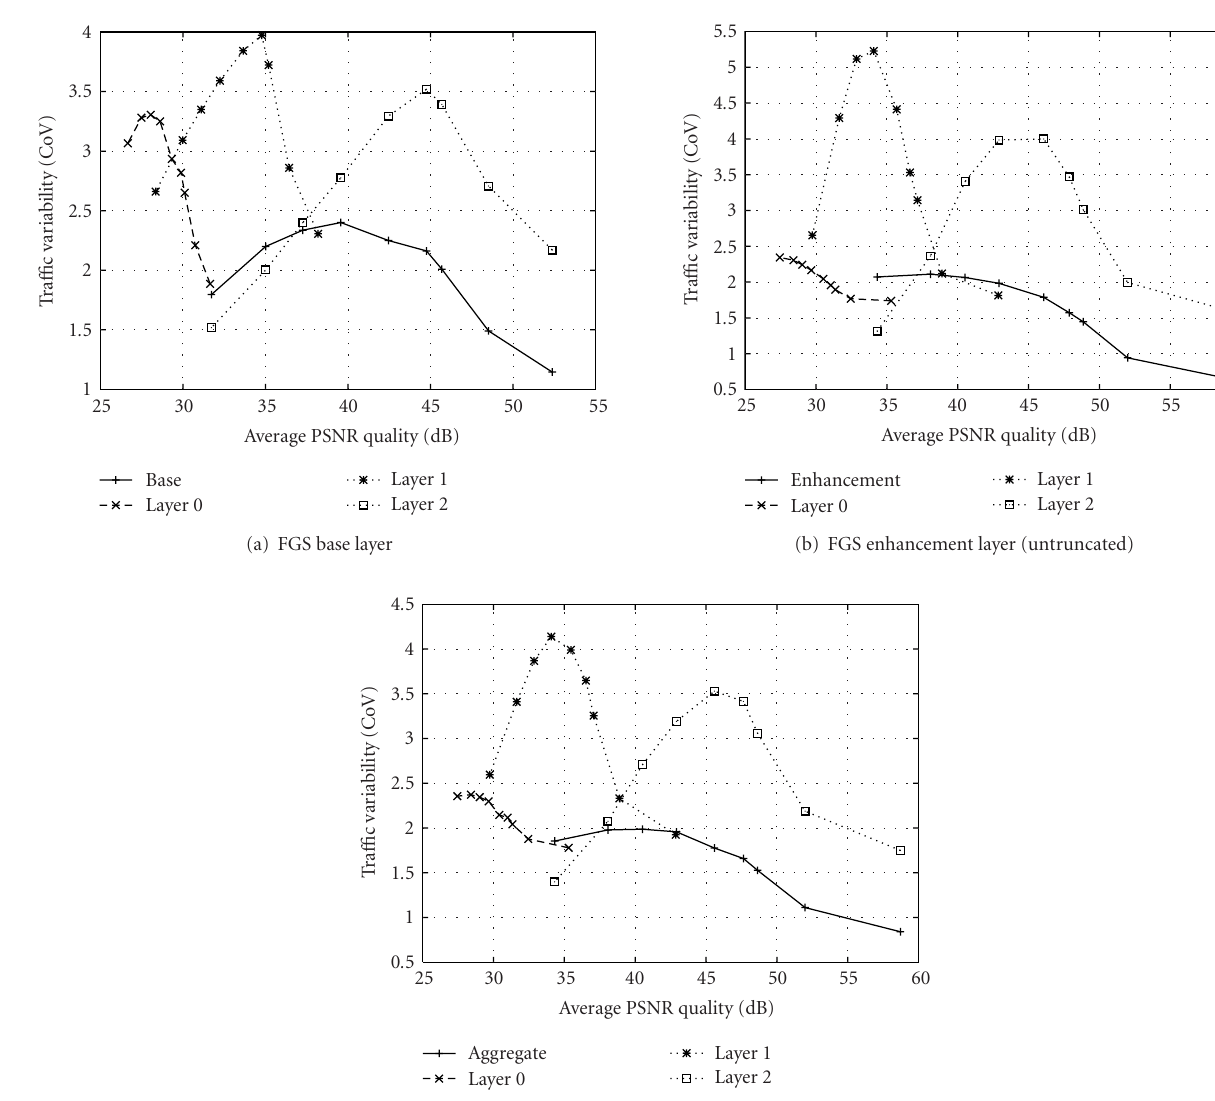
Figure 11: VD curves of all temporal layers ( 0 , 1 , 2 ) embedded in each FGS layer and in the aggregated (base + untruncated enhancement) tra ffi c stream, for the Silence of the Lambs sequence encoded with SVC FGS ( G16-B3 ).